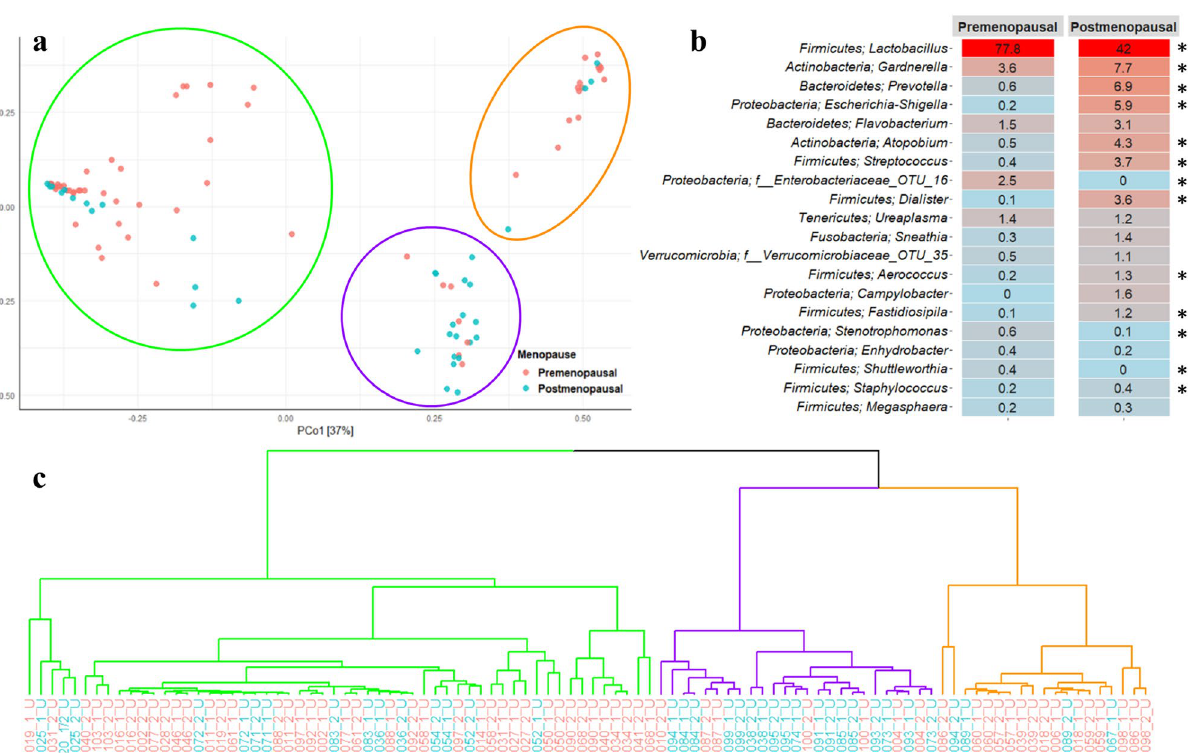
Figure 2. The bacterial composition in urine samples from pre- and postmenopausal women. ( a ) PCoA plot using Bray Curtis dissimilarity. Three urotypes were identified, as indicated with green, purple and orange circles. ( b ) Heatmap, indicating the 20 most abundant bacterial genera in the urine, as well as percentage of total OTUs. Red and blue respectively indicates high and low relative abundance. *Benjamin Hochberg adjusted p value < 0.01. ( c ) Dendrogram obtained with hierarchical clustering of OTU diversity in samples, based on the PCoA plot. Branch colors represent urotype, while label color represent menopausal state: red indicate premenopausal women, whereas blue represent postmenopausal